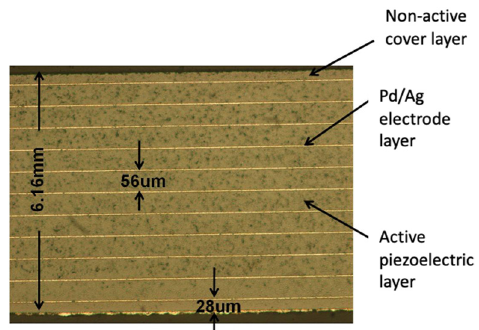
Figure 9. Ten-layer piezoelectric bimorph stator with 56 µm per layer.